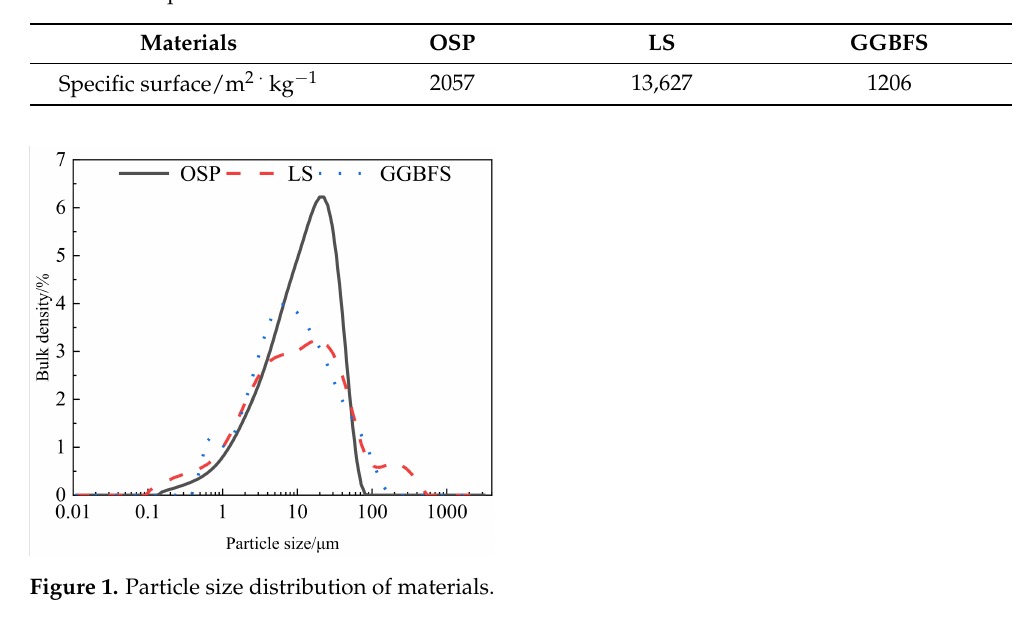
Table 2. The specific surface area of the materials.